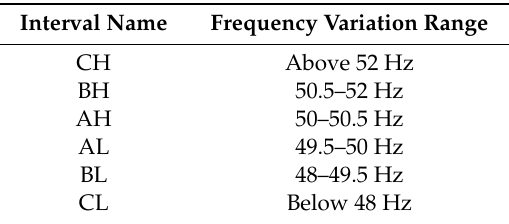
Table 3. Frequency